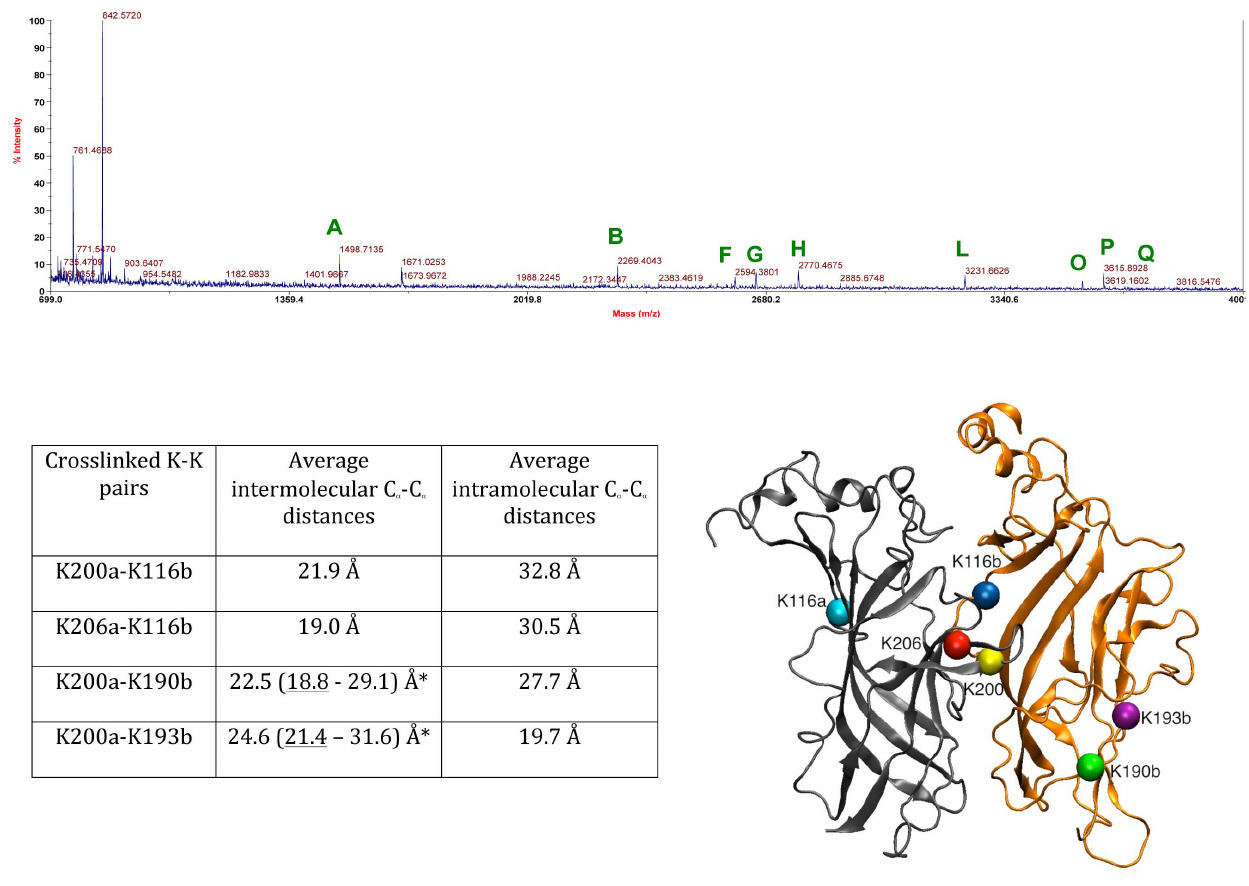
Figure 5. Intra-/inter-molecular crosslinks observed in GlyBP by MALDI-TOF MS analysis after crosslinking with DMS. Representative mass spectrum of tryptic digest of excised higher molecular weight GlyBP band is shown in the top panel. Mass peaks assigned as crosslinked peptides are labeled and further identified in Table 2 . Average C a -C a Lys-Lys distances measured along the MD trajectory of assigned crosslinks are provided in the panel below. The calculation of distances is averaged over all 5 subunits/interfaces over the 2 ns long MD trajectory. a and b indices distinguish adjacent GlyBP monomers in a pentamer. The positions of the Lys residues in two neighboring subunits of the GlyBP model are shown in bottom right. The protein structure is shown in grey and gold color in cartoon representation and C a atoms of Lys residues are shown as colored spheres. * the range of distances reflect variations the average distance between subunits in the MD trajectory; while upper range distances are greater that the crosslinker length, the flexibility of the C loop in GlyBP brings the distances (underlined) well within the crosslinker arm length.